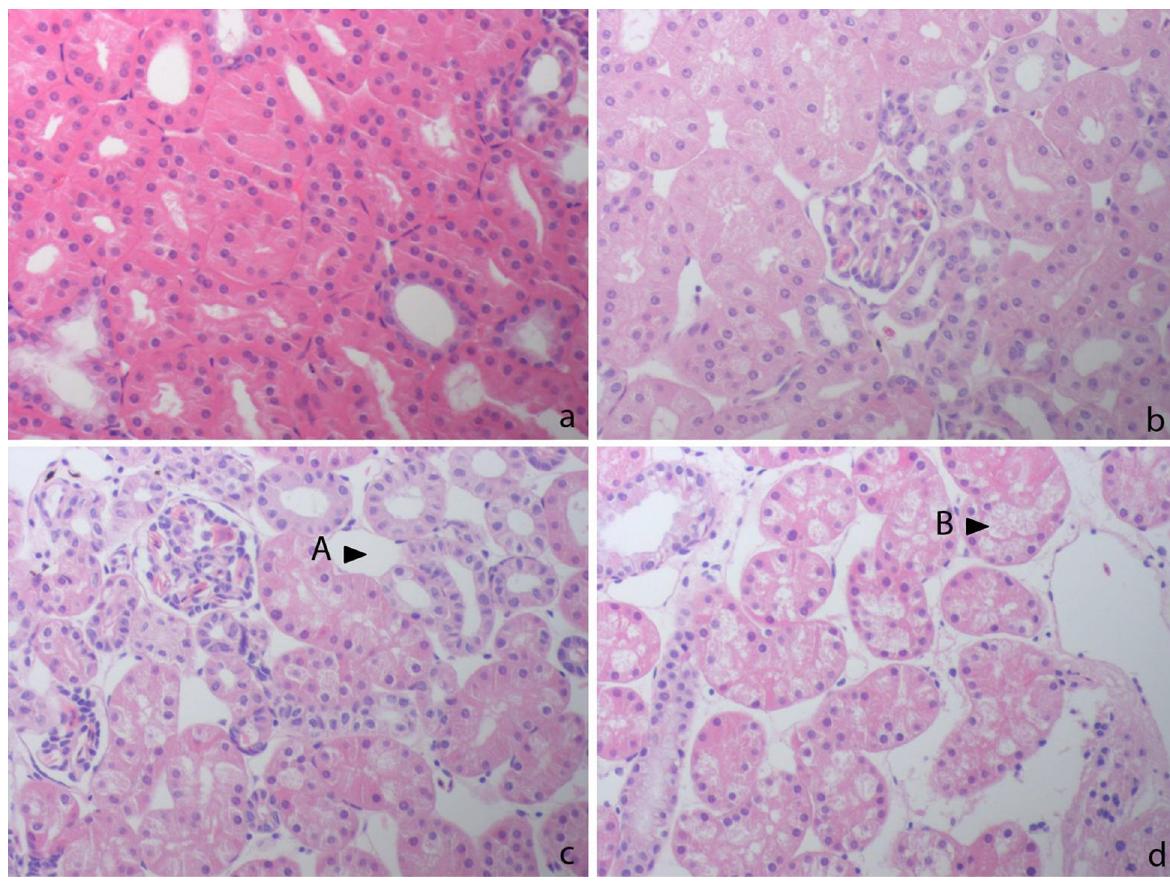
Fig 7. Histologic findings in the kidneys; 200 x; HE staining. a: Control animal, stage 0; no alterations in kidney parenchyma b: stage 1; mild interstitial edema, mild tubular vacuolization c: stage 2; moderate tubular vacuolisation, moderate interstitial edema (A) d: stage 3; severe tubular vacuolisation (B), tubular lumina are absent, severe interstitial